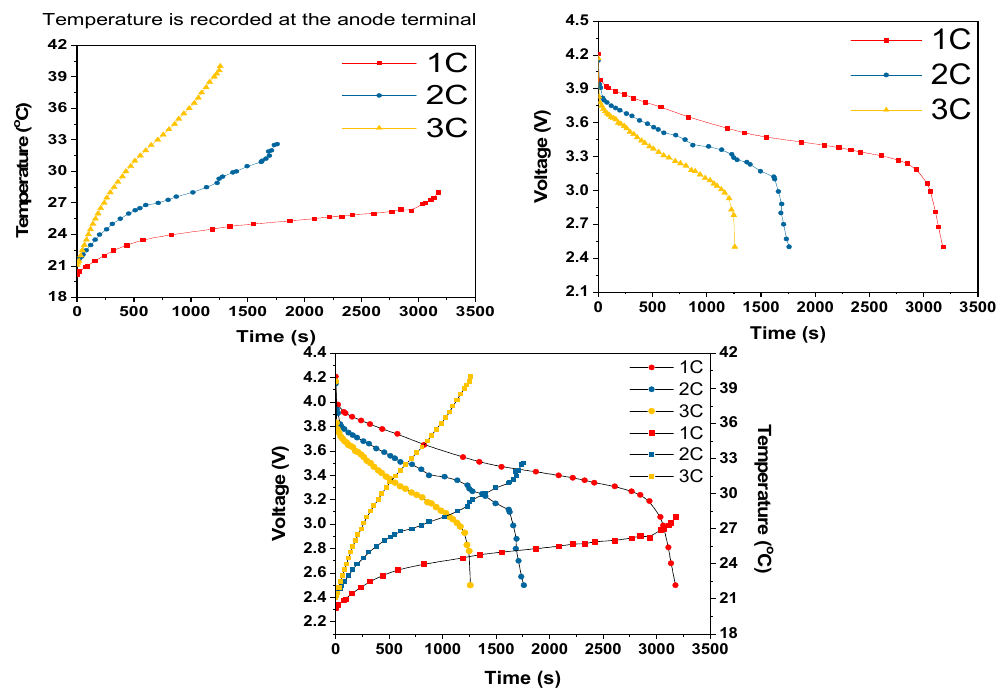
Figure 10. Measured single-cell battery voltage and terminal temperature versus time for 1C, 2C, and 3C dry discharge rates.